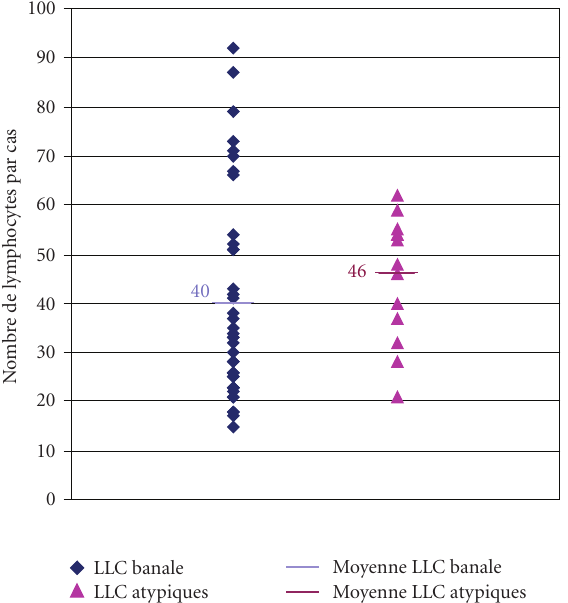
Figure 6: Average numbers of captured lymphocytes functions of the morphologic type of CLL.